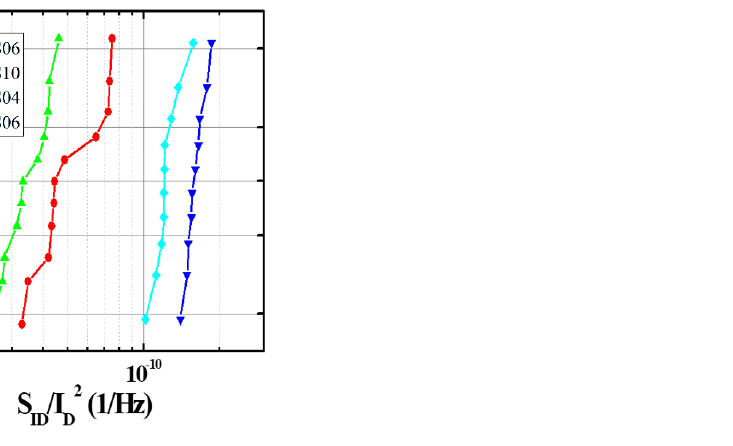
Figure 8. Cumulative probability curves of the low-frequency noise characteristics extracted at 10 Hz from the 11 devices for each of the four types of a-Si microbolometers. Table 3. Comparison of values at the midpoint (50%) of the cumulative curves plotted in Figure 8 of the four types of a-Si microbolometers.